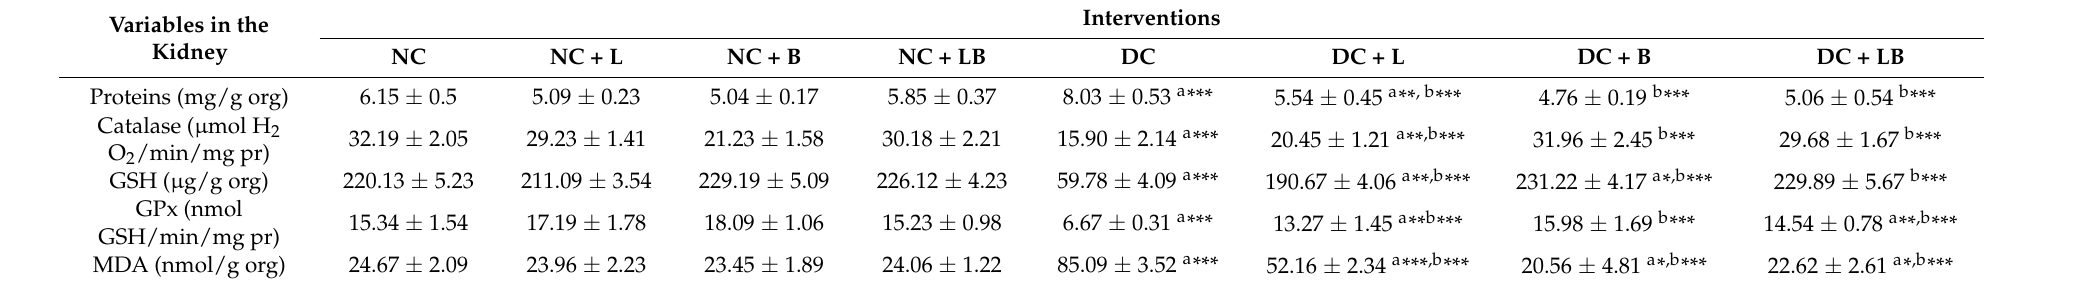
Table 4. Effect of the different treatments on the oxidative parameters in the kidney (mean ± SD).